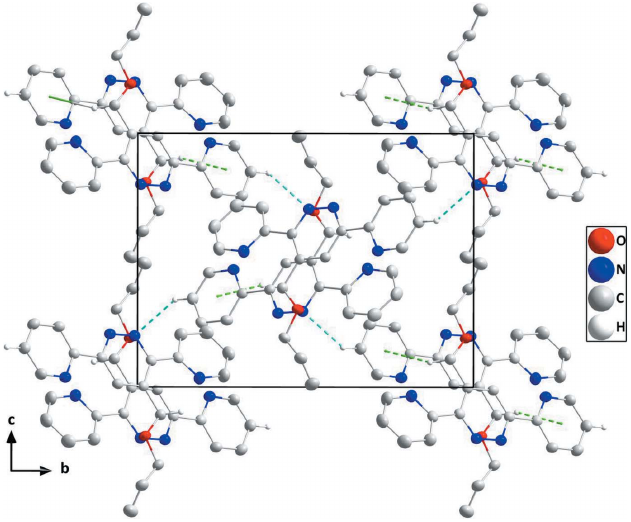
Figure 2 A partial packing diagram viewed along the a -axis direction with C—